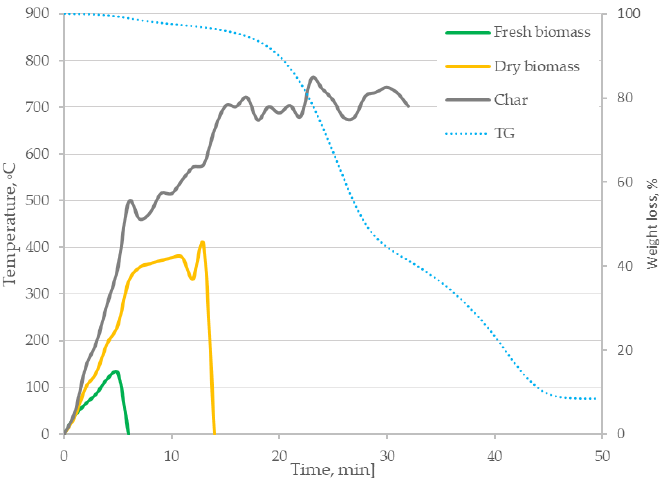
Figure 9. Change in the temperature of fresh biomass, dry biomass and char — sample 10K90J.